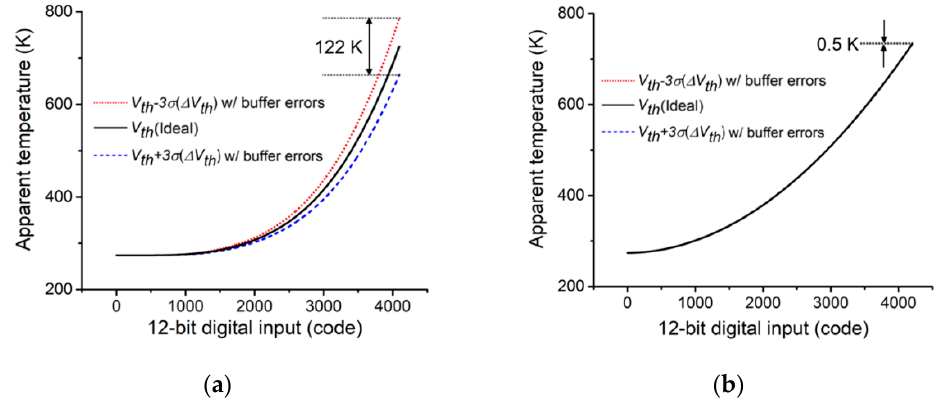
Figure 8. Apparent temperature analysis of IR emitter: ( a ) conventional RIIC; ( b ) proposed RIIC.